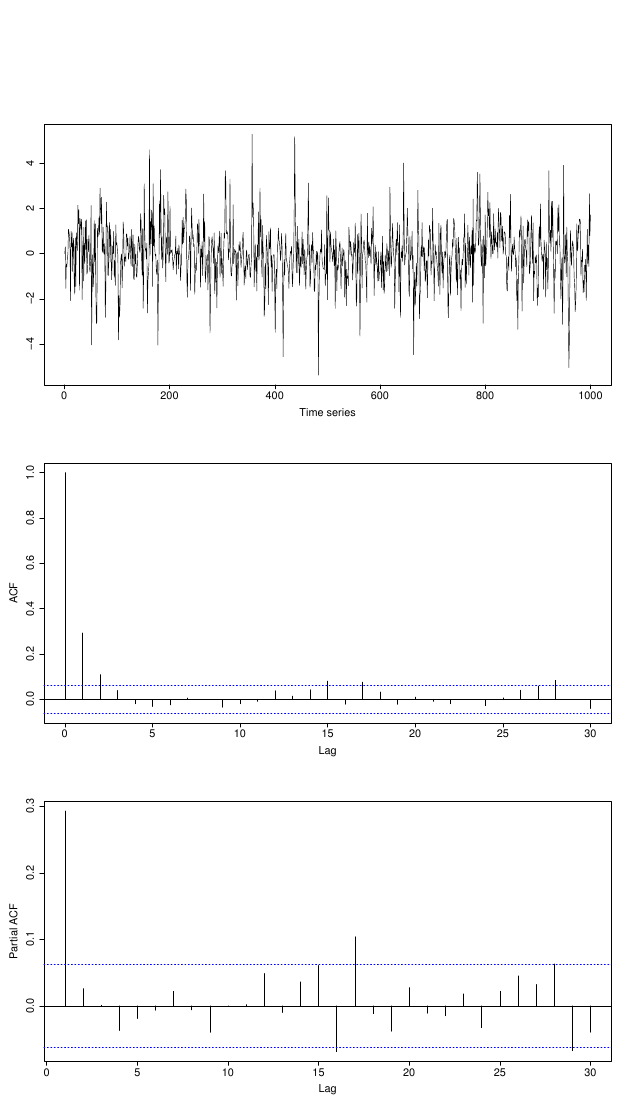
Figure 3 – Simulated time series, ACF, PACF plots corresponding to a = 0.3, θ =